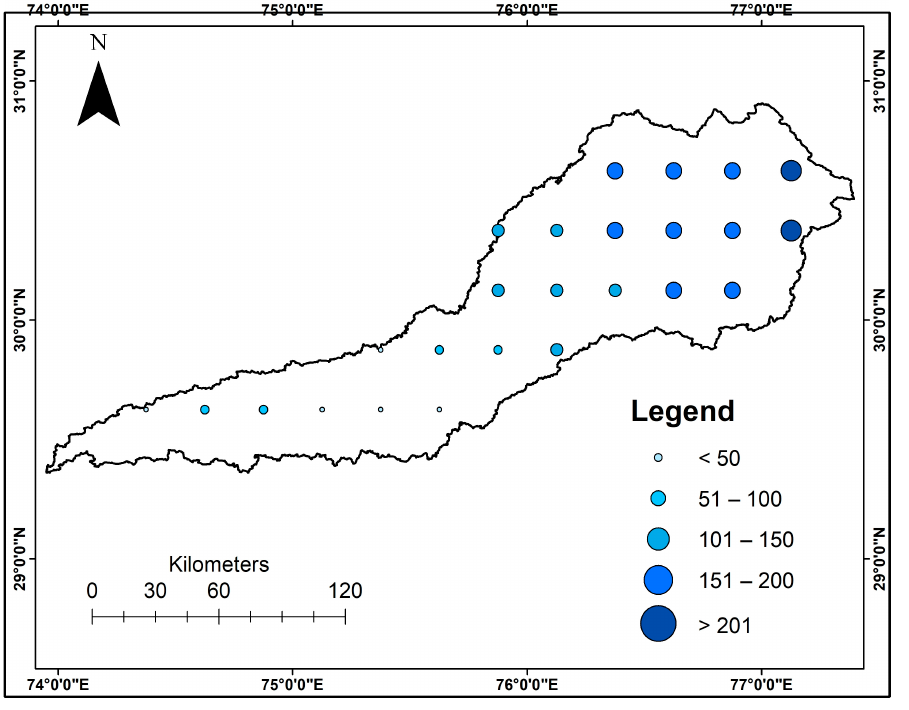
Figure 12. Interpolated rainfall distribution in the study region (Source: chrsdata.eng.uci.edu).